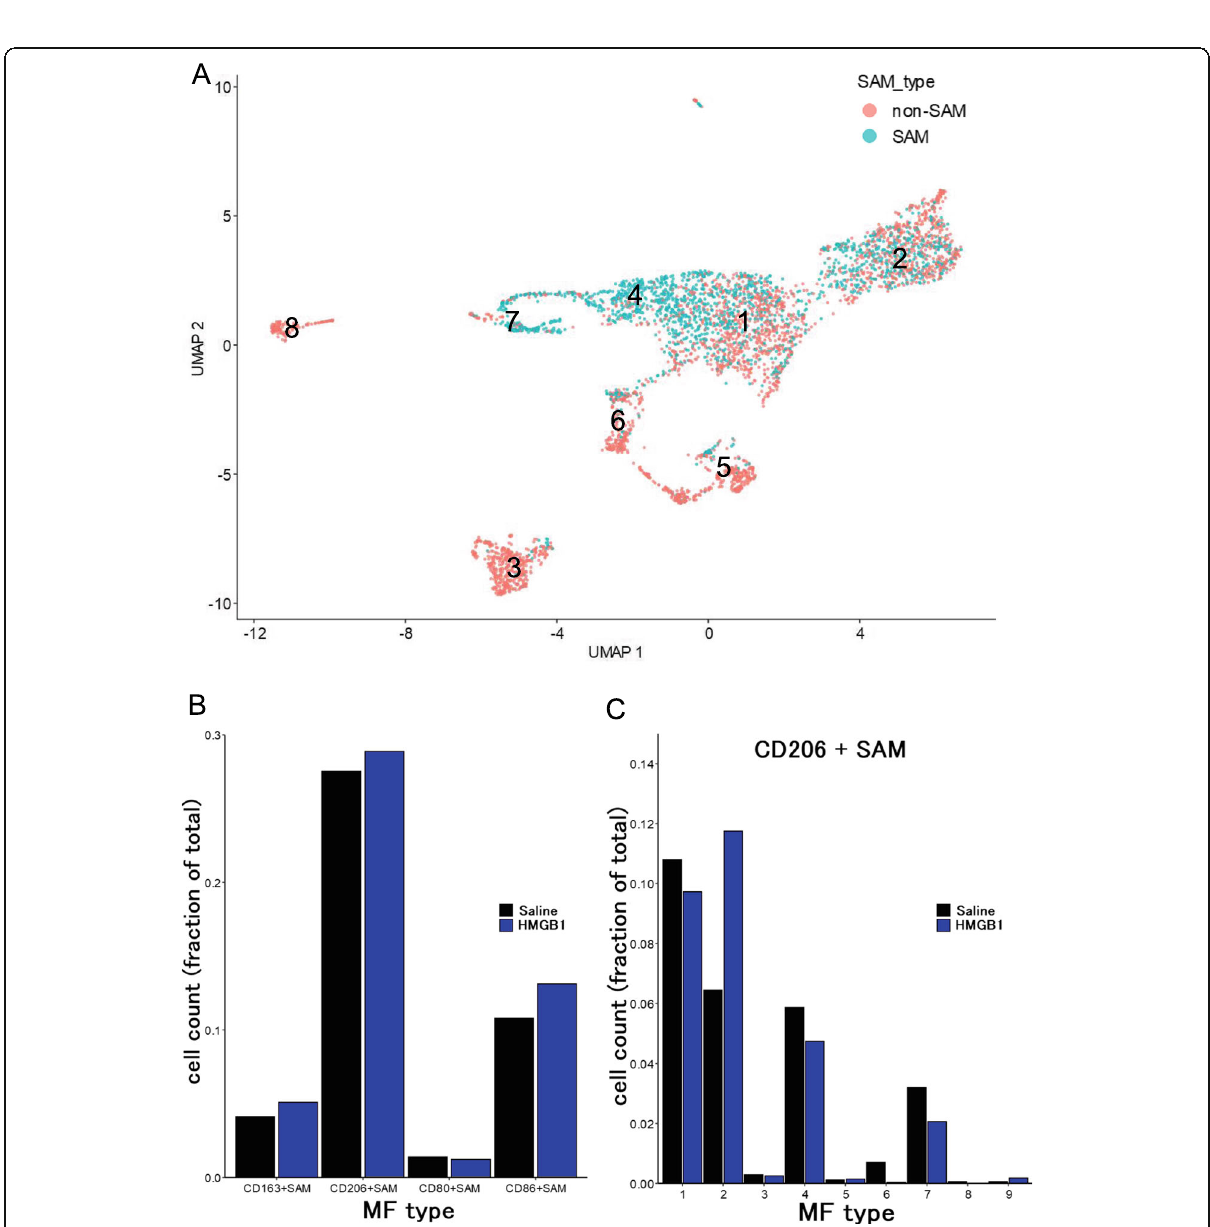
Fig. 6 Detailed analysis of scar-associated macrophages (SAMs). A the distribution of SAMs and non-SAMs are shown. B the number of the cells of SAMs co-express inflammatory M1 markers (CD80 or CD86) or anti-inflammatory M2 markers (CD163 or CD206) are shown. C The frequency of CD206+SAMs in each macrophage